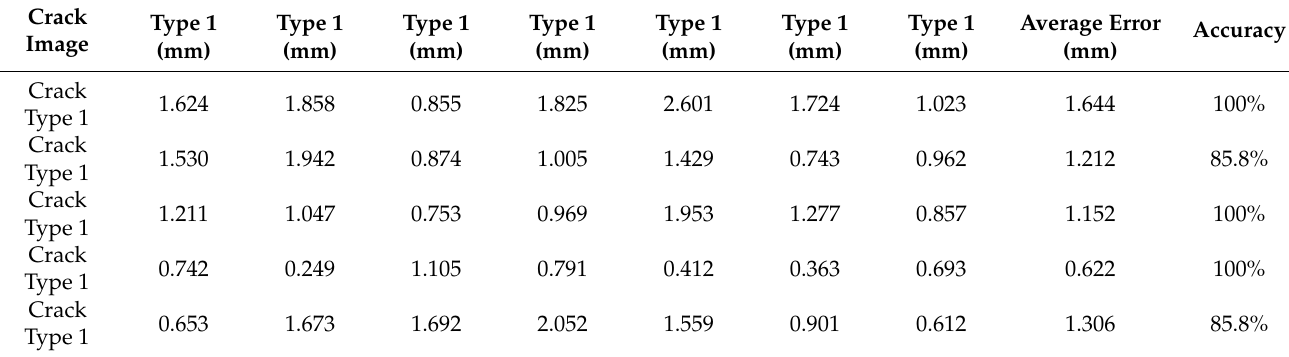
Figure 21. Prototype crack fitting experiment results. Table 4. Radial error of fitted trajectory